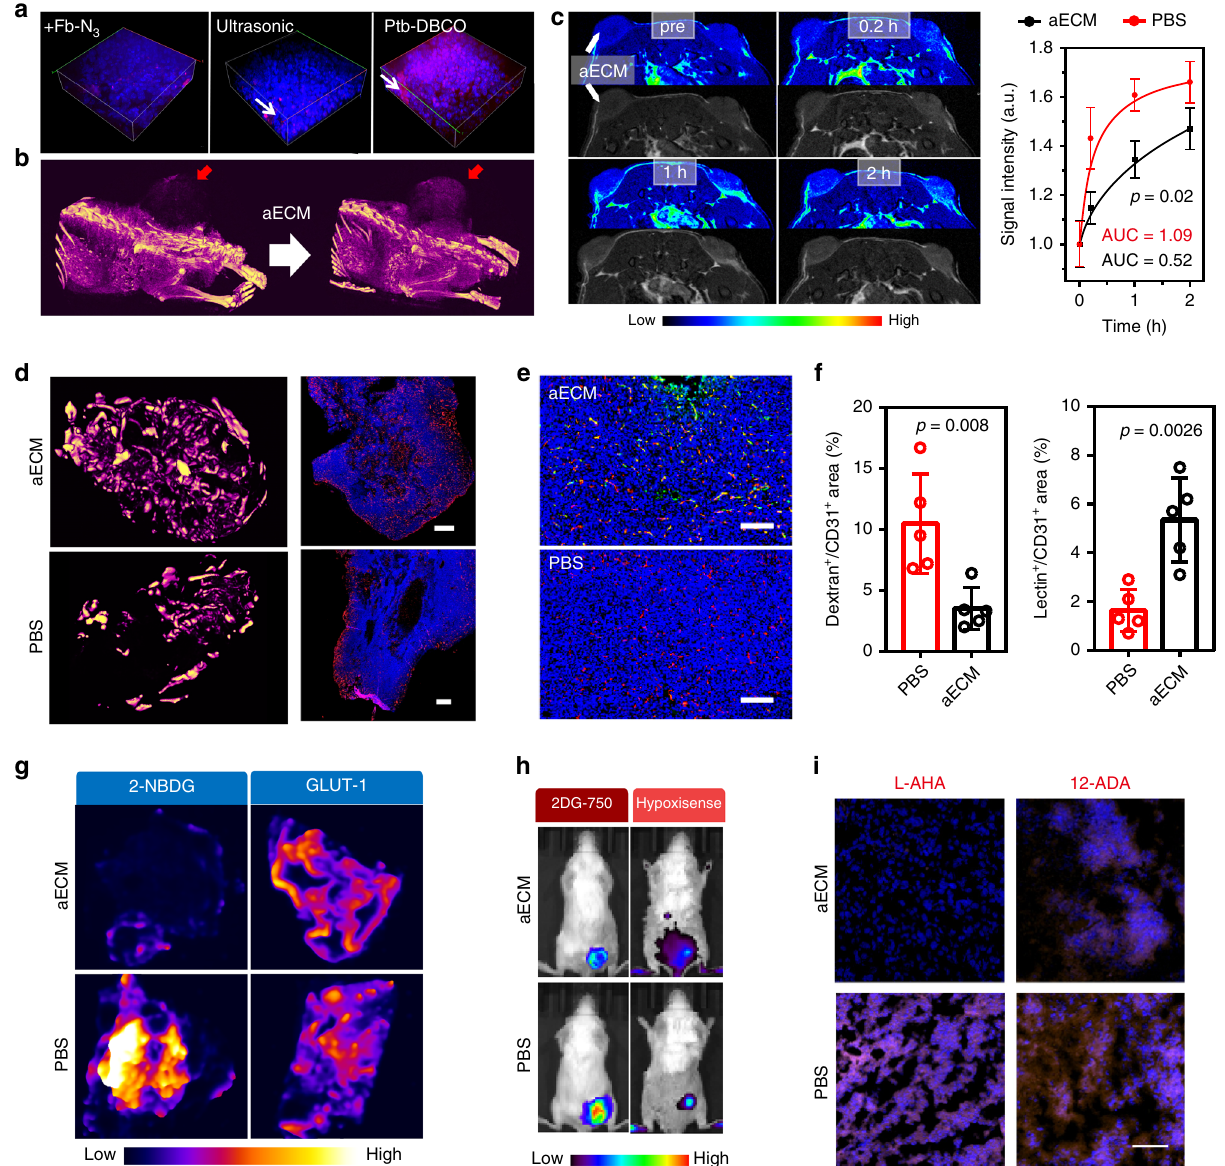
Fig. 5 In vivo biological activity of aECM. a 3D tumor fl uorescence imaging before and after aECM treatment (red: rhodamine B isothiocyanate-labeled fi brinogen; blue: Hochest 33342-strained cells). A representative image of three biological replicates is shown. White arrows indicate the aECM gelation. b µ -CT imaging of mice before and after treatment with diatrizoic acid-conjugated aECM. A representative image of three biological replicates is shown. Red arrows denote aECM gelation. c The T1-weighted MRI imaging was performed on bilateral tumor-bearing mice, and the representative images and quantitative results of tumors treatment with PBS (right) or aECM (left) are presented. A representative image of three biological replicates is shown. Arrows denote tumor positions. d μ -CT imaging for visualizing the three-dimensional structure of tumor vessels. Tumor sections were stained for CD31 (scale bar: 500 μ m). A representative image of three biological replicates is shown. e CD31 and α -SMA immunostaining of tumor vessels. Tumor sections were stained for CD31 (red) and α -SMA (green) (scale bar: 200 μ m). Five images per group were taken. f Quantitative analysis of dextran leakage and lectin perfusion of tumor vessels. The tumor sections were stained for CD31 (red). Dextran + or lectin + area is presented as a percentage per total sectional or CD31 + area ( n = 5 fi elds). g The effect of aECM in suppressing glucose uptake and glycolysis. h In vivo fl uorescence imaging of 2-DG 750 (100 μ L) and HypoxiSense 680 (100 μ L) for indicating the performances of aECM in affecting tumor glucose uptake and hypoxia. A representative image of three biological replicates is shown. i The effect of aECM in suppressing lipid and amino acid uptake. Tumors of 12-ADA- or L-AHA-treated mice were collected 24 h later, and stained with DBCO-Cy5 ( n = 5 fi elds, scale bar: 100 μ m). Signi fi cance between two groups ( c , f ) was calculated by using two- tailed Student ’ s t- test. The mean values and SD are